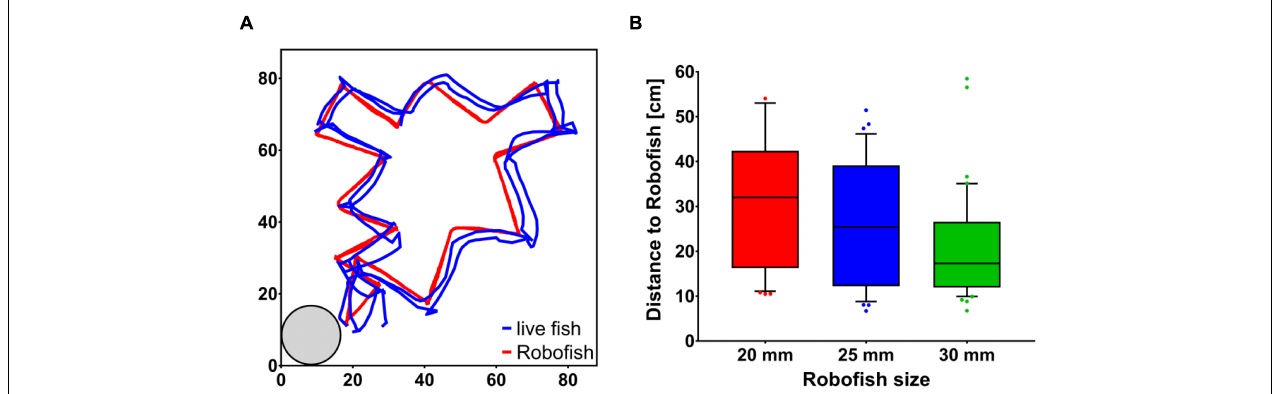
FIGURE 2 | Following behavior of live guppies toward differently sized Robofish replicas. (A) Example track of a trial with Robofish. Fish were introduced into the start box (gray circle, lower left corner) and released into the tank after 1 min. Robofish then moved on a predefined zig-zag trajectory through the tank until it reached its start position. This movement was repeated a second time and a trial lasted about 60 s in total. (B) Inter-individual distance (Distance to Robofish) between live fish and differentially-sized Robofish replicas. Shown are medians and interquartile ranges (whiskers at 10 and 90% percentiles, with outliers as